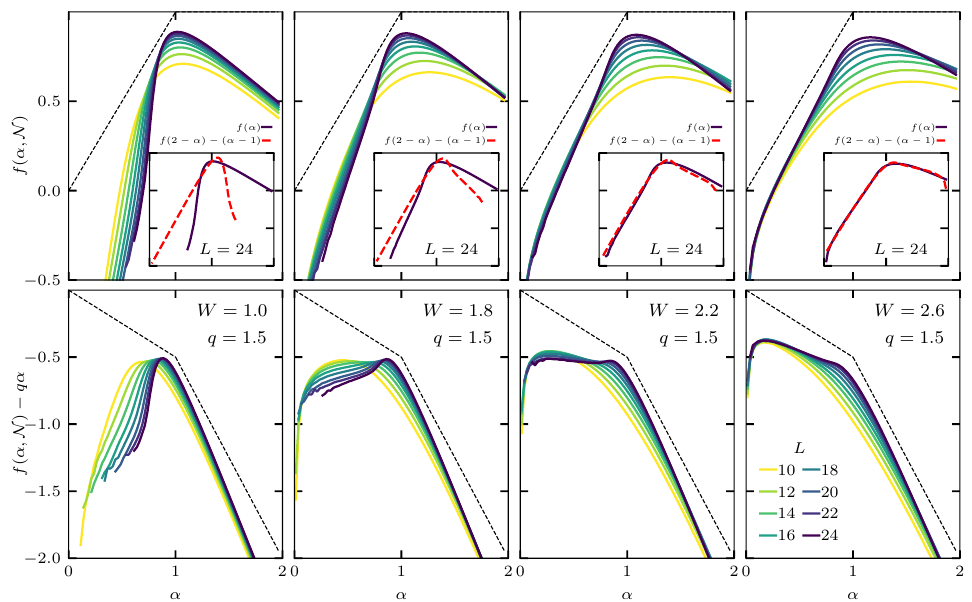
Figure 7: Upper row . The finite size multifractal spectrum f ( α , N ) for small values of α and L = 12,16,20,24 (darker colors, correspond to larger system sizes). Dashed black lines indicate the upper bounds on f ( α ) according to (13). The insets show f ( α , N ) (solid black lines) for the maximal available size ( L = 24 ) together with its multifractally symmetric counterpart according to Eq. (16) (dashed red lines). Lower row . Same as the upper row, but for the tilted multifractal spectrum, f ( α , N ) − q α , and q =